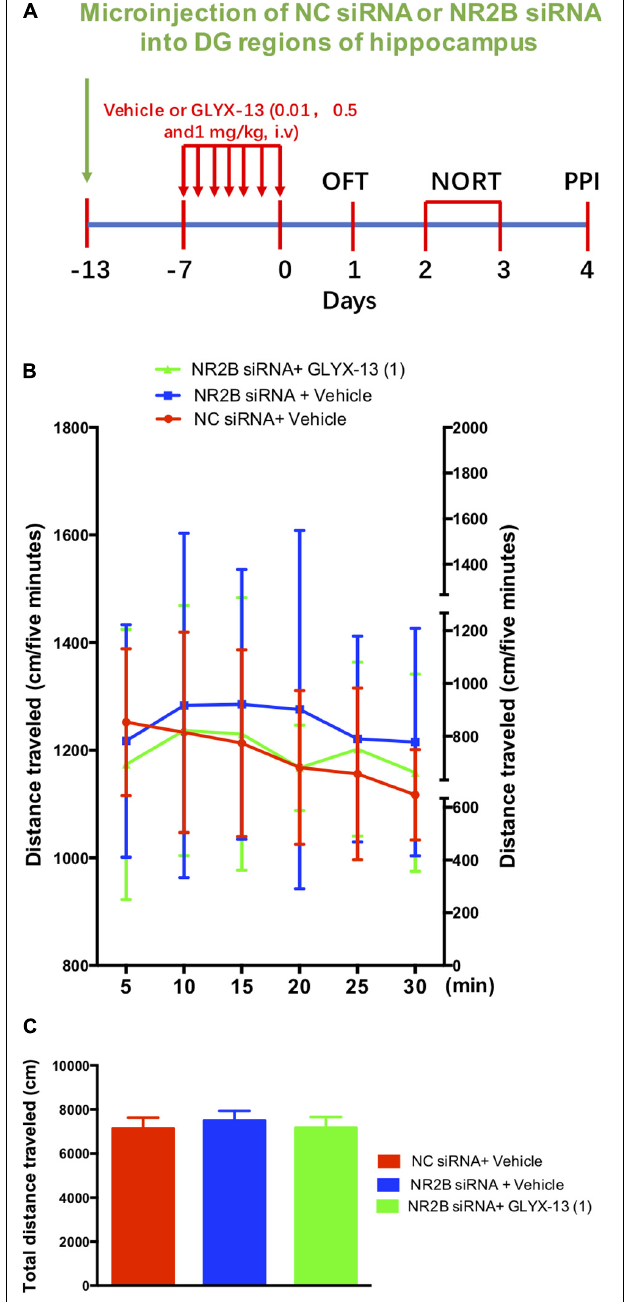
FIGURE 6 | GLYX-13 did not change the locomotor activity NR2B siRNA knockdown mice. (A) Experimental time line. (B) Horizontal locomotor activity was examined as the distance traveled (cm) in 30 min. The distances traveled in 5 min intervals (B) and the total distance traveled in 30 min (C) are shown. Data are expressed as means ± SEM ( n = 12).